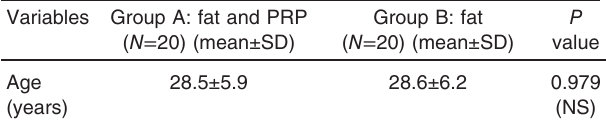
Table 1 Demographic characteristics in both groups Variables Group A: fat and PRP ( N = 20)